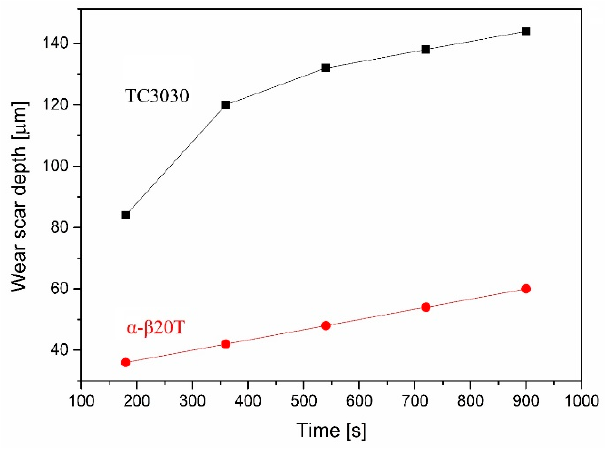
Figure 8. Wear scar depth variation with time corresponding to α - β 20T and TC3030 ceramics.